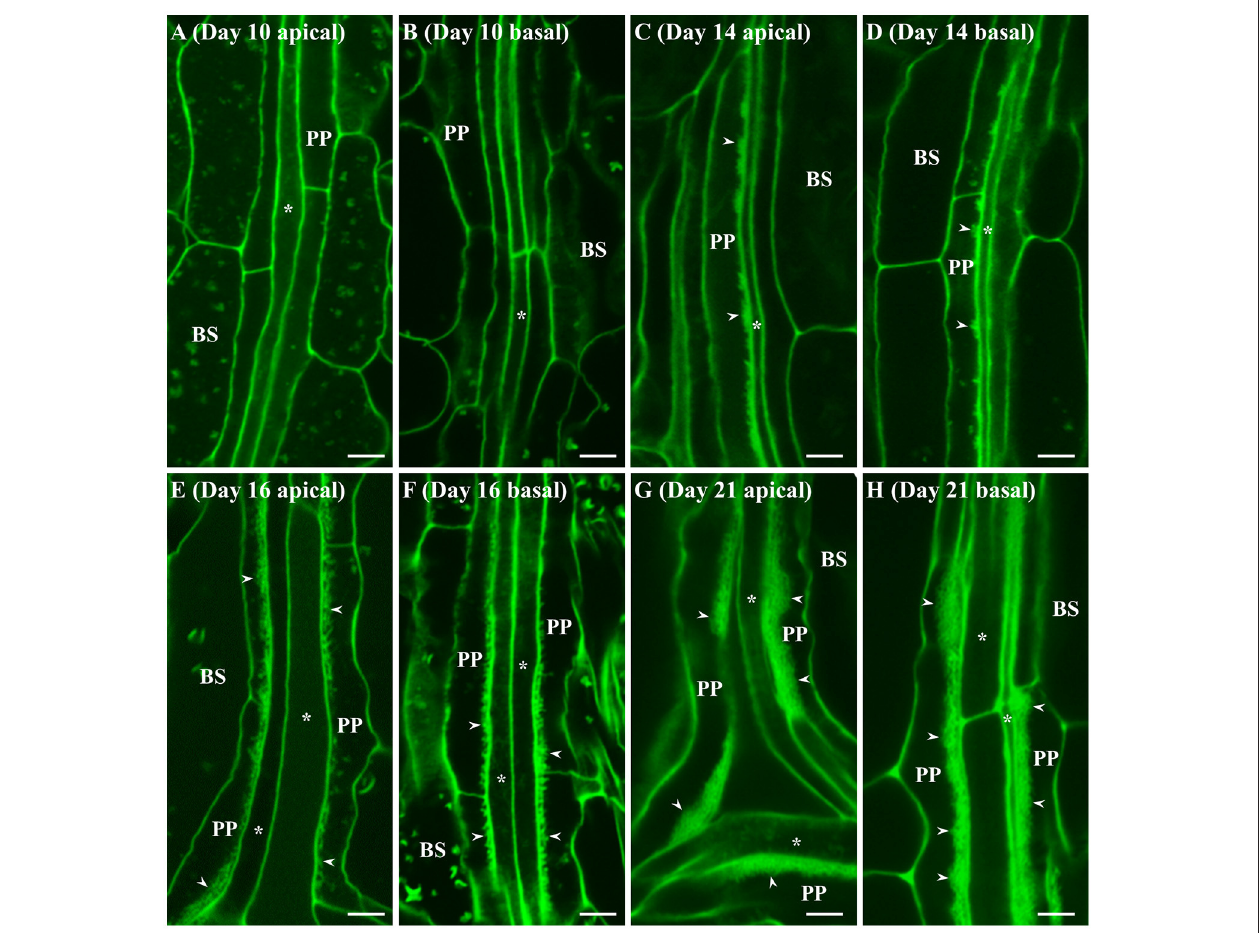
FIGURE 2 | Confocal imaging of wall ingrowth deposition in PP TCs of Leaf 1 and 2 from Arabidopsis. At day 10, no wall ingrowths were detected in PP TCs in either apical (A) or basal (B) halves of the leaf. By day 14, the apical half of Leaf 1 and 2 (C) displayed dense clusters of wall ingrowths in PP TCs but this was less abundant in basal regions (D) . By day 16, continuous bands of wall ingrowth deposition were seen in PP TCs in both apical (E) and basal (F) regions of the leaf. At day 21, thick layers of wall ingrowth were deposited along the entire PP TC border in both apical (G) and basal (H) regions of the leaf. BS denotes bundle sheath cells; asterisks indicate SE/CCs; PP denotes PP cell or PP TC, as appropriate; arrowheads indicate wall ingrowths in PP TCs. The fluorescent fragments occasionally seen in BS and PP cells correspond to remnant starch grains not completely extracted by the bleach treatment. Scale bars = 5 µ